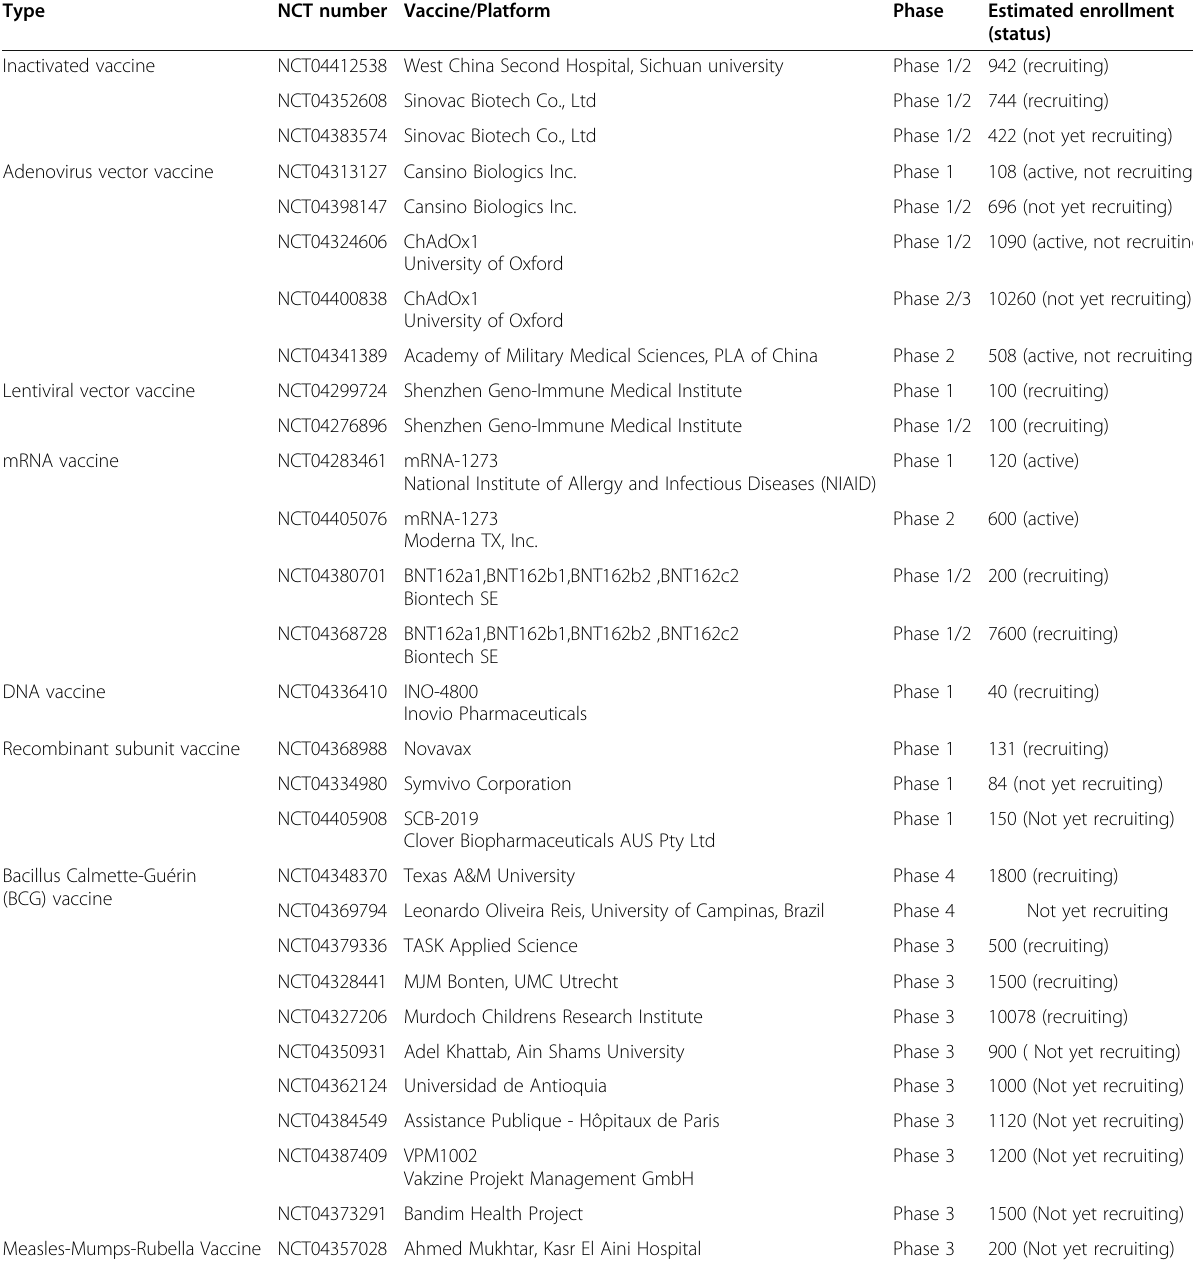
Table 1 Ongoing and future clinical trials of COVID-19 vaccines